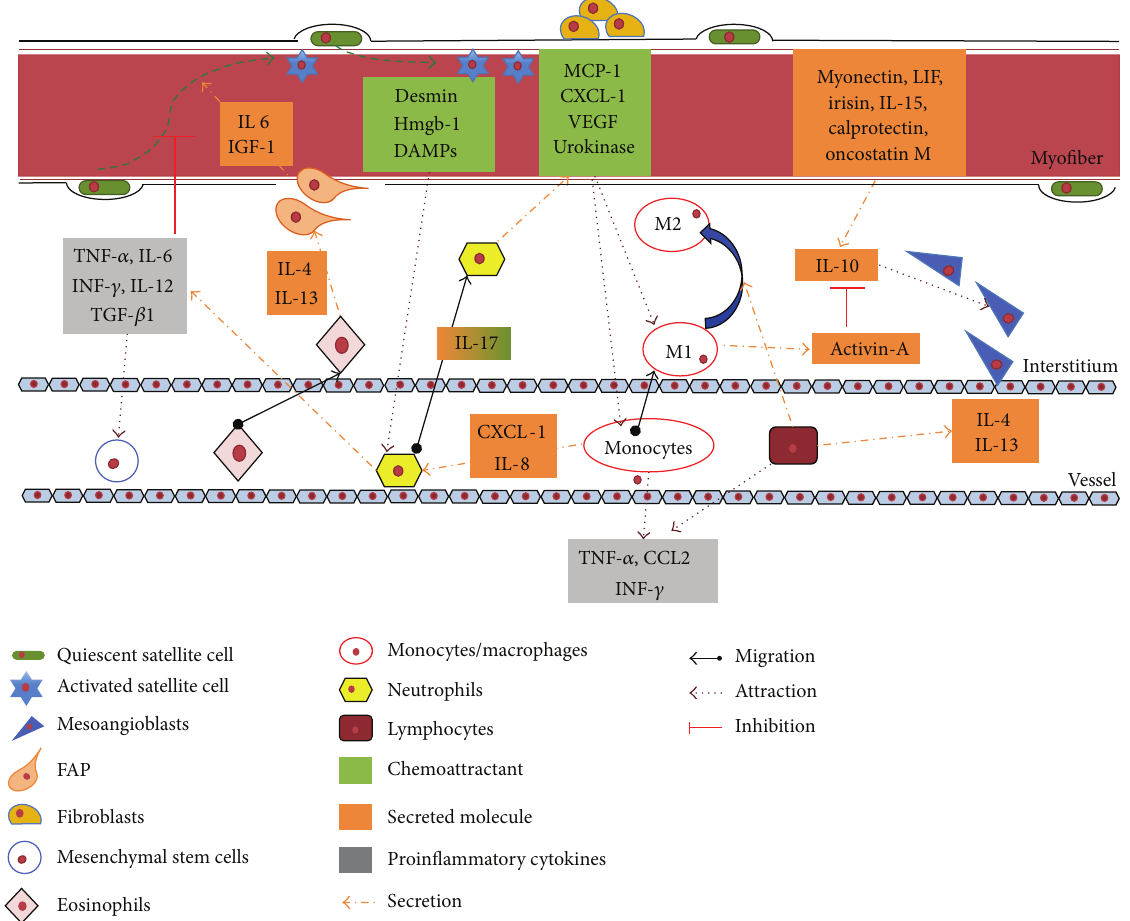
Figure 2: Secreted molecules and paracrine effects from resident and circulating cells involved in skeletal muscle inflammation.